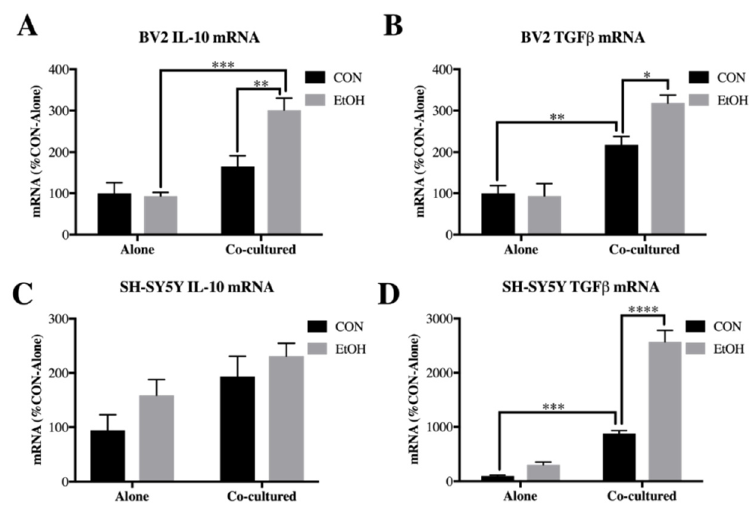
Figure 8. IL-10 and TGF β are increased by ethanol in co-cultured BV2 microglia and SH-SY5Y. BV2 microglia and SH-SY5Y were treated with ethanol (EtOH, 100 mM) for 24 h either alone or while co-cultured. Cell lysates were examined for mRNA expression. ( A ) IL-10 expression was increased by EtOH in co-cultured BV2 (182 ± 17%). ( B ) TGF β was increased by co-culture (217 ± 20%) and by EtOH in co-cultured BV2 (319 ± 19%). ( C ) IL-10 expression in SH-SY5Y. ( D ) TGF β expression was increased by co-culture (880 ± 53%) and by EtOH in co-cultured SH-SY5Y (2571 ± 221%). Data is represented as %CON (control)-Alone, n = 5–6 per group. * p < 0.05, ** p < 0.01, *** p < 0.001, **** p < 0.0001 via